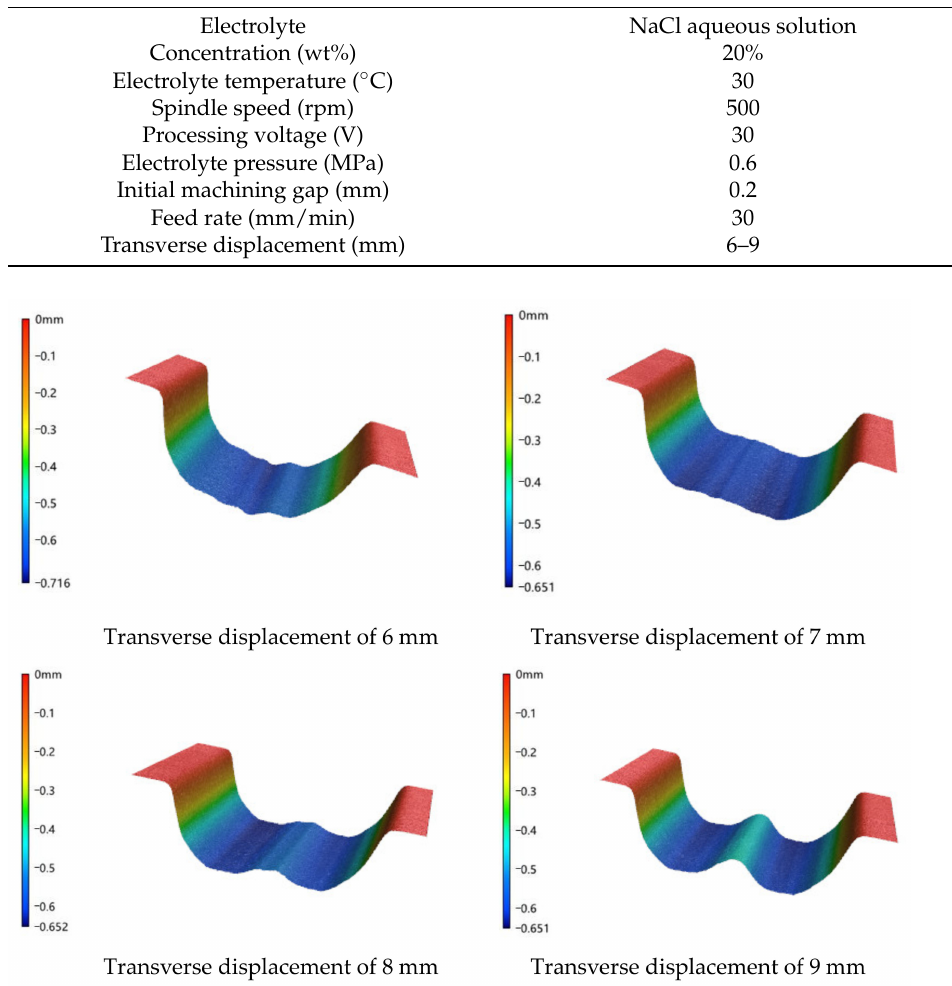
Figure 11. Different transverse movements of the corresponding gear